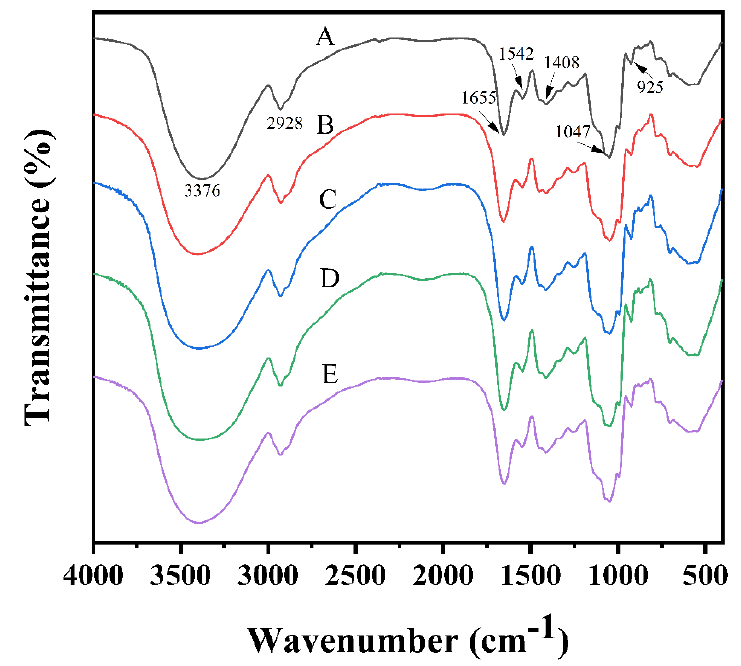
Figure 4. Infrared spectra of milk tea subjected to different stabilizers.